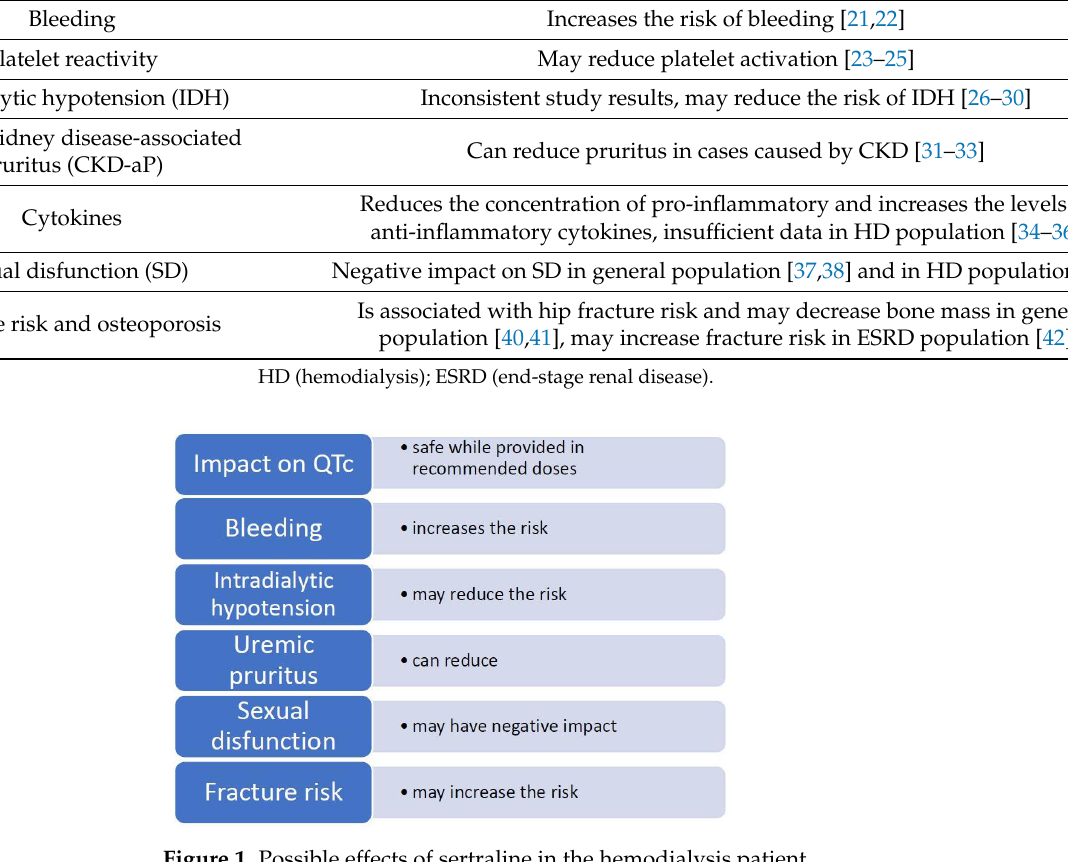
Figure 1. Possible effects of sertraline in the hemodialysis patient.